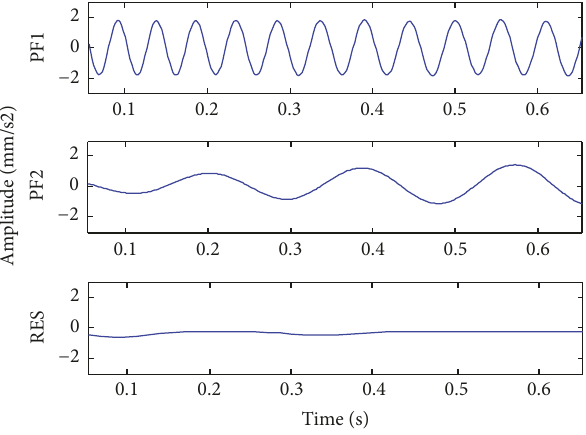
Figure 5: LMD results of the SVR-based extension